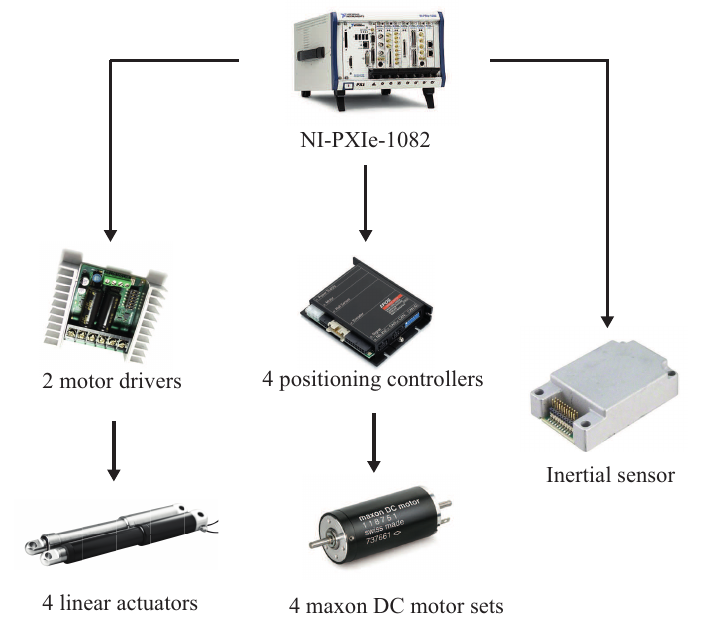
Figure 2. Components of the